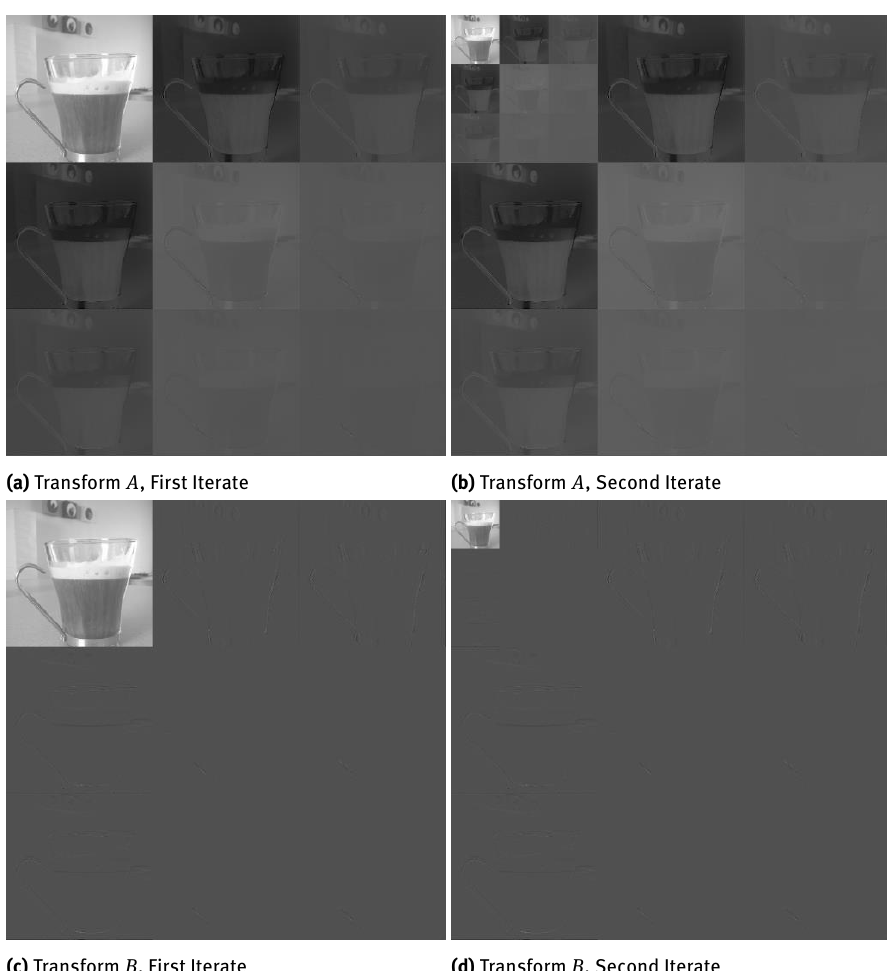
Figure 3: Generalized discrete wavelet transform for matrices A and B